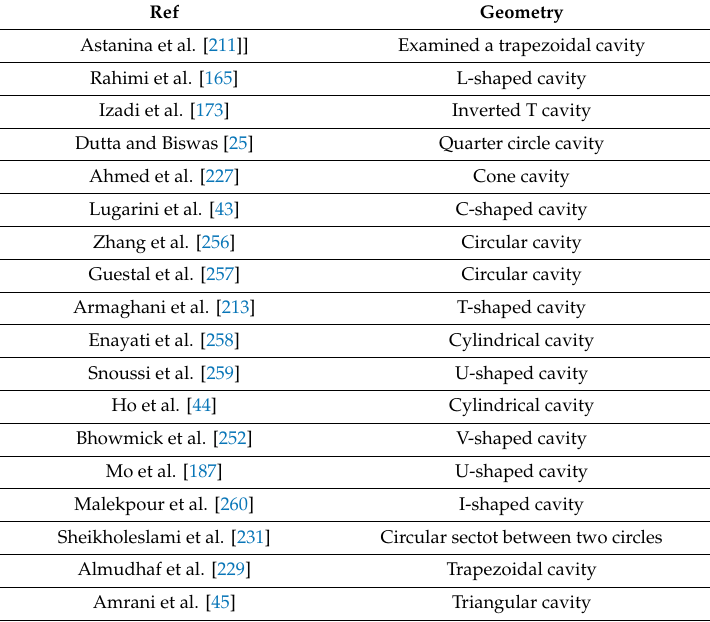
Table 13. Summaries of papers on non-rectangular cavities.